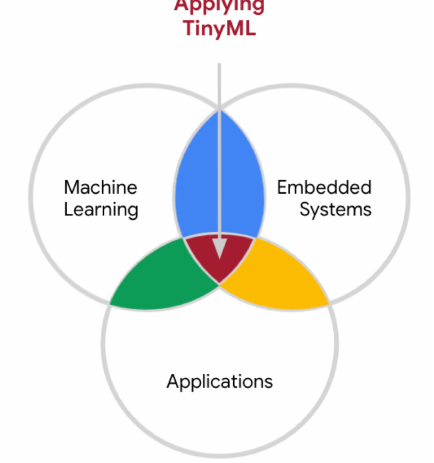
Figure 2. Tiny Machine Learning (TinyML) is focused on enabling new applications through the deployment of machine learning models onto embedded